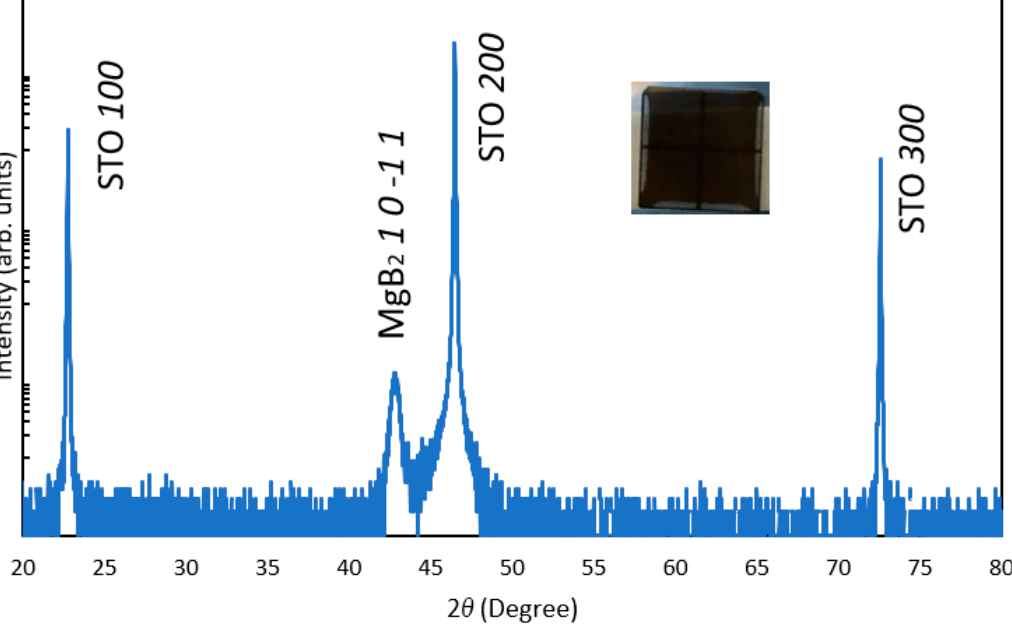
Figure 1. Out-of-plane XRD pattern of prepared MgB 2 film. The inset image shows the appearance of the as-deposited MgB 2 film on the STO substrate.